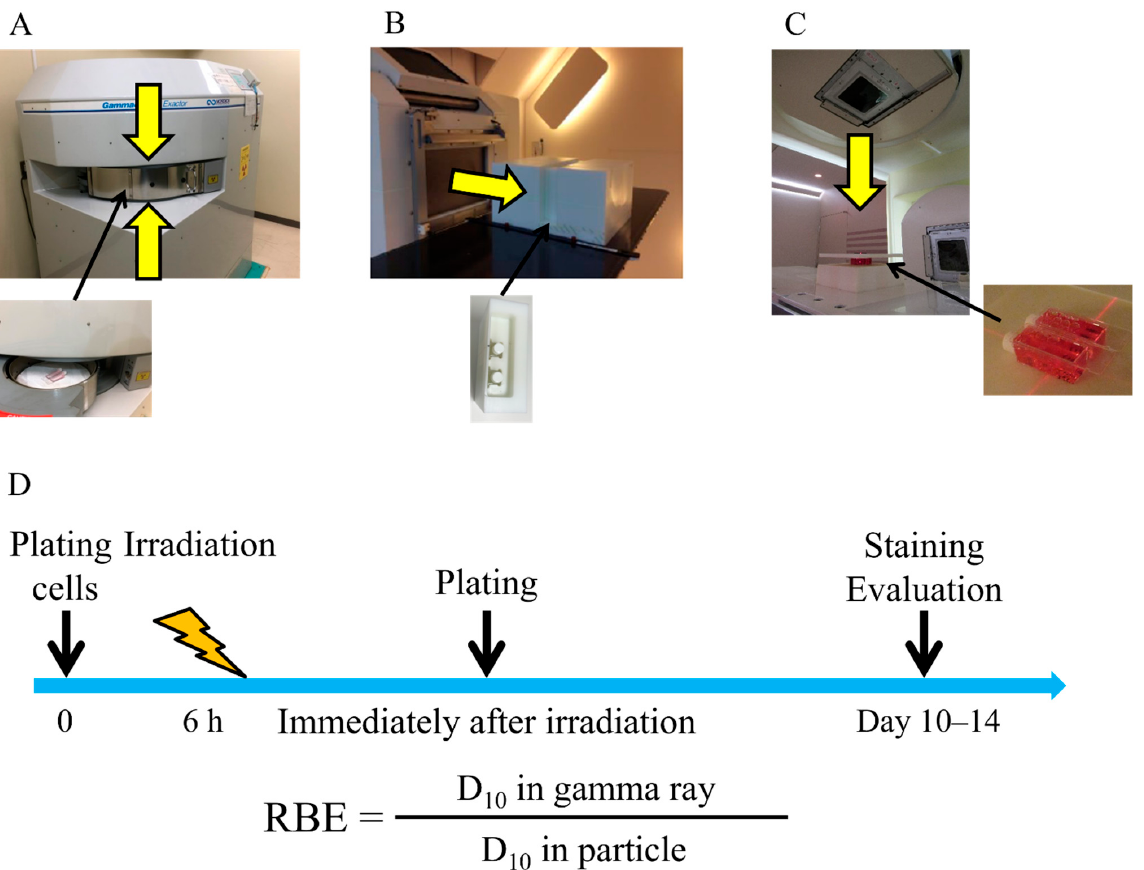
Figure 5. Experimental setup. ( A ) Experimental setup of gamma ray irradiation. ( B ) Experimental setup of proton beam irradiation at Hokkaido University. ( C ) Experimental setup of carbon-ion ir- radiation at Hyogo Ion Beam Medical Center. ( D ) Overall schedule of the colony formation